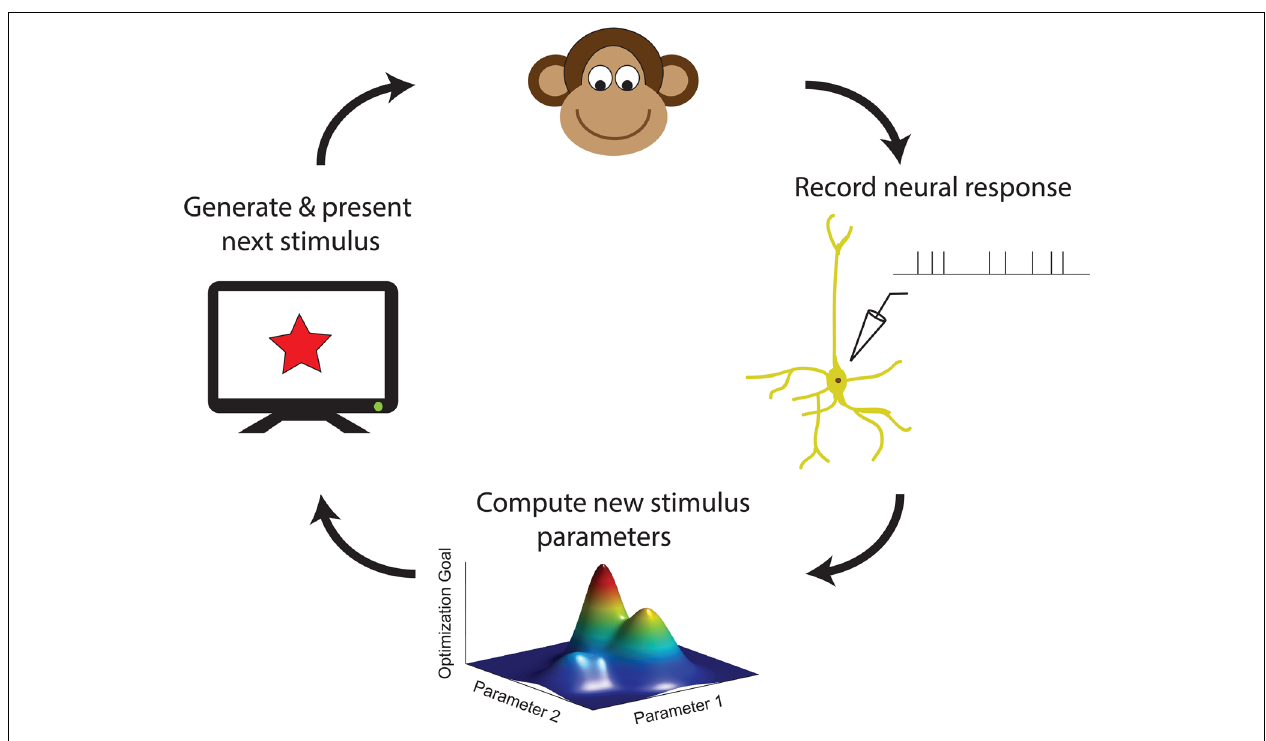
FIGURE 7 |A schematic summary of closed-loop approaches in sensory neurophysiology. Neural responses to previous stimuli are used in order to choose new stimuli, by maximizing an objective function for accomplishing a desired experimental goal (see also Table 1